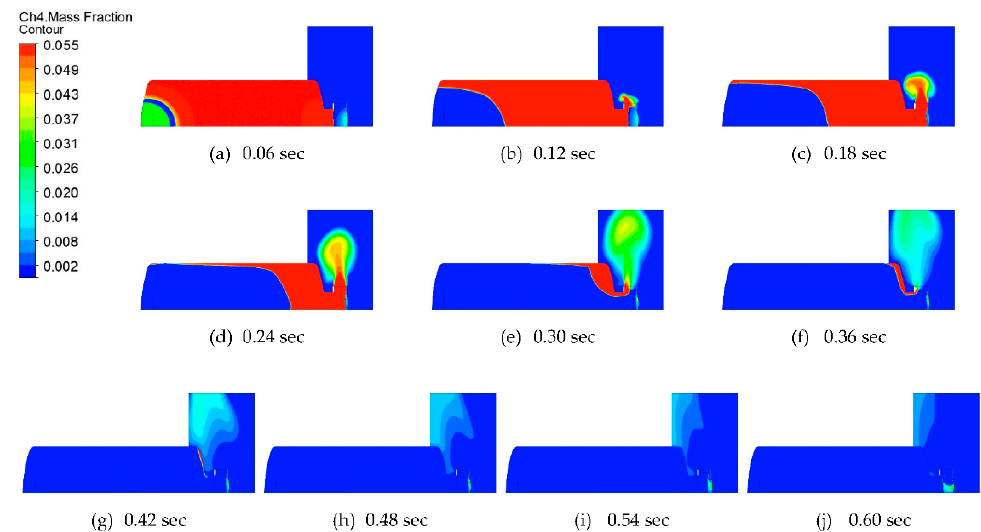
Figure 5. CH 4 Mass Fraction contour results after the explosion.